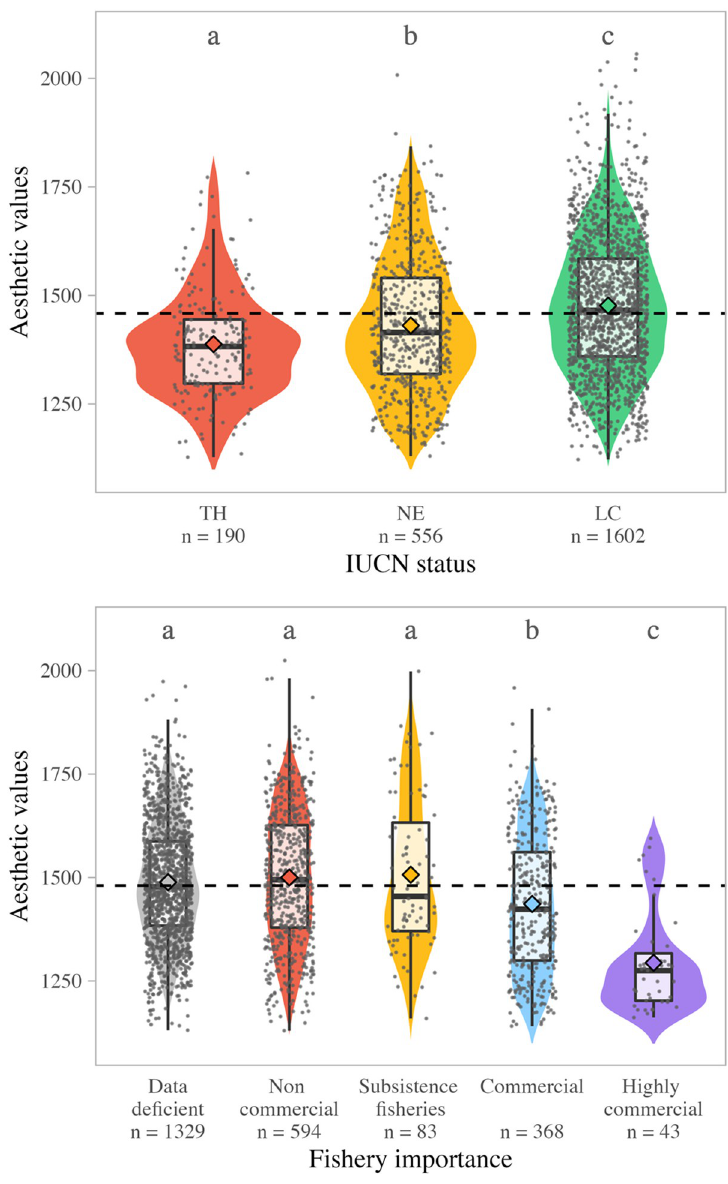
Fig 5. Fish aesthetic value and conservation status. AU : AbbreviationlisthasbeencompiledforthoseusedinFig 5 : Pleaseverifythatallentriesarecorrect : (a) Violin plot of the aesthetic value of reef fishes for three groups of conservation status: TH, NE, and LC. Letters indicate significant differences between the groups (Tukey p - values are respectively p < 0.01 between TH and NE, p < 0.001 between LC and TH, and p < 0.001 between LC and NE). (b) Violin plot of the aesthetic value of reef fishes for the 5 groups of fishery importance: “Data deficient” = no data available; “Non commercial” = no interest for fisheries or potential interest or minor interest; “Subsistence fisheries” = importance for subsistence fisheries; “Commercial” = commercial importance for fisheries; “Highly commercial” = high commercial importance for fisheries. Letters indicate significant differences between the groups (all Tukey p -values are < 0.002). Data and code required to generate this Figure can be found in https://github.com/ nmouquet/RLS_AESTHE. LC, Least Concern; NE, Not Evaluated; TH, Threatened.